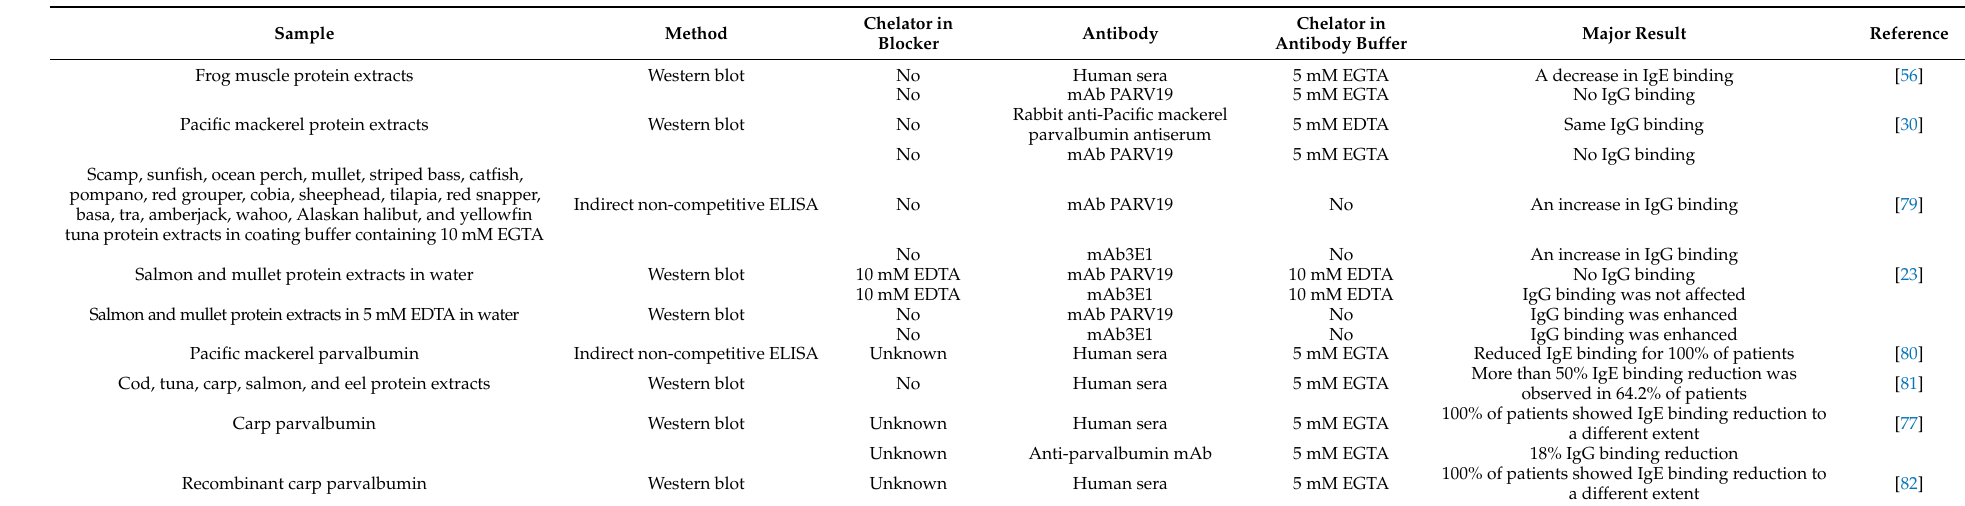
Table 3. Effect of calcium ion on parvalbumin